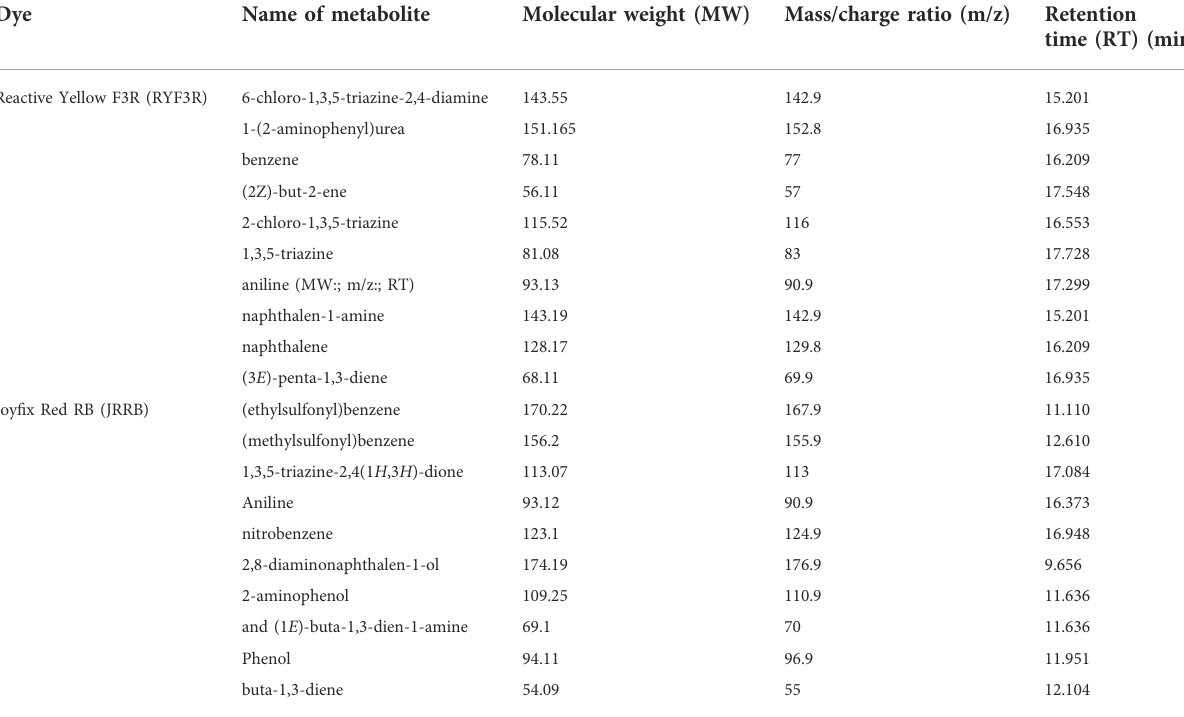
TABLE 3 GCMS spectral data of biodegradation products of RYF3R and JRRB, degraded by L. sphaericus MTCC 9523. Dye Name of metabolite